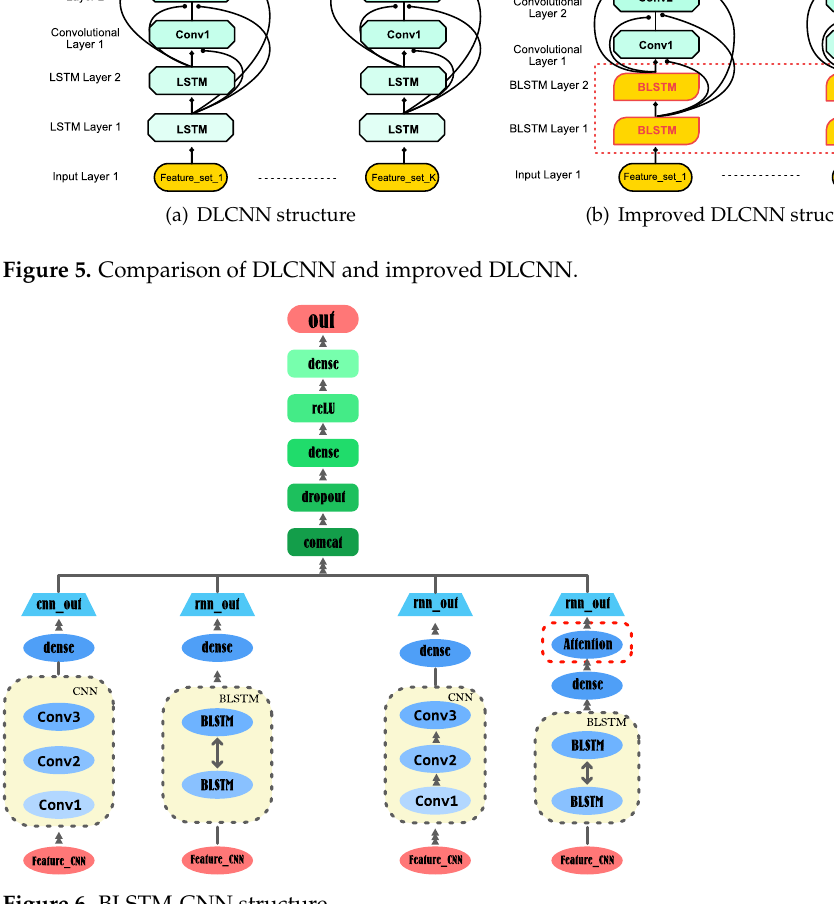
Figure 6. BLSTM-CNN